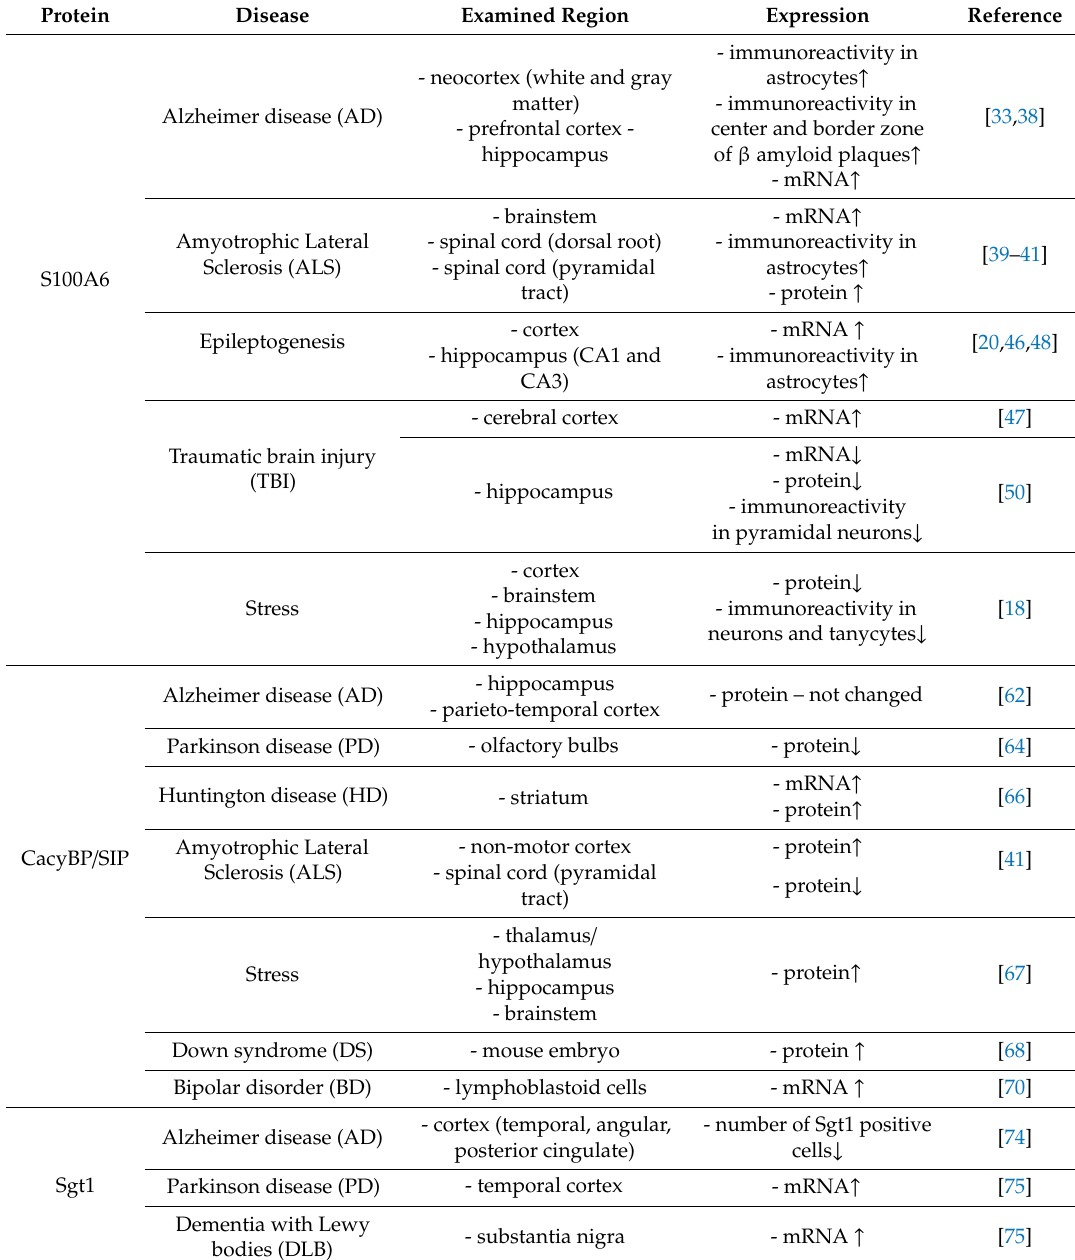
Table 1. Changes in S100A6, CacyBP / SIP, and Sgt1 expression in neurodegenerative